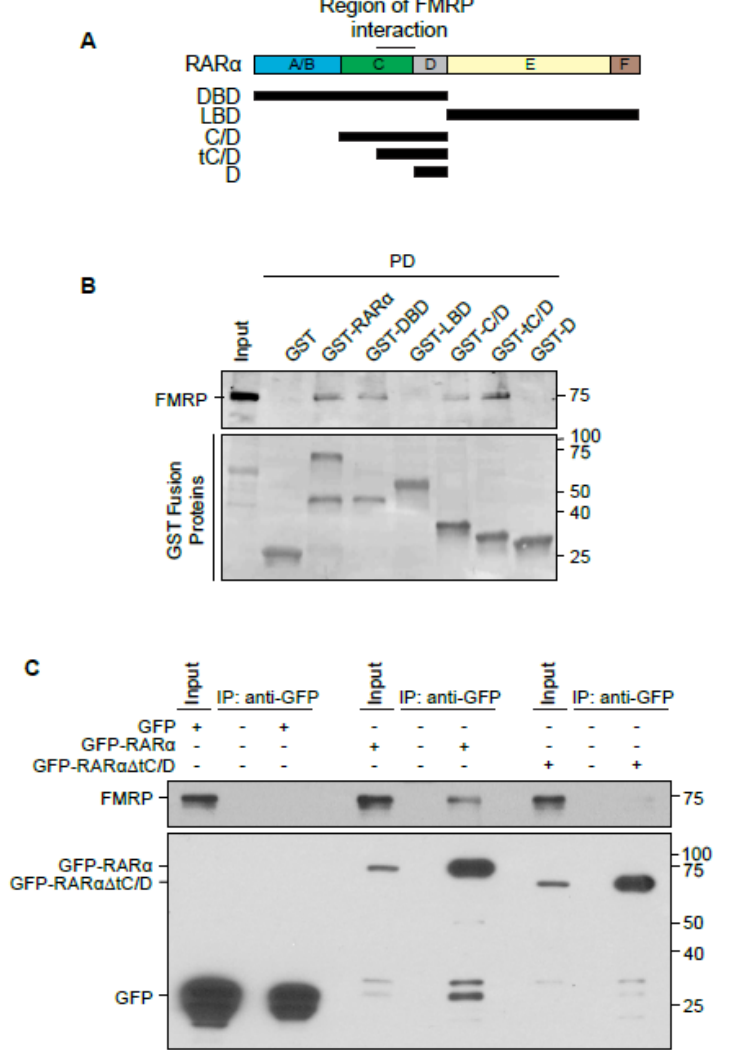
Figure 2. Determination of RAR α domains important for the interaction with FMRP. ( A ) Schematics of RAR α domain organizations and truncation mutants used for interaction assays. All fusion proteins contain an N-terminal GST tag. ( B ) GST-tagged purified RAR α truncation mutants from ( A ) were incubated with HEK cell lysates; pull-down of endogenous FMRP in P30 mouse hippocampal lysates was detected by immunoblot (top panel). Coomassie blue staining shows expression levels of truncation mutants (bottom panel). ( C ) Immunoprecipitation of endogenous FMRP (top panel) in HEK cells transfected with GFP, GFP-RAR α , and GFP-RAR α ∆ tC/D (bottom panel) using anti-GFP antibodies.